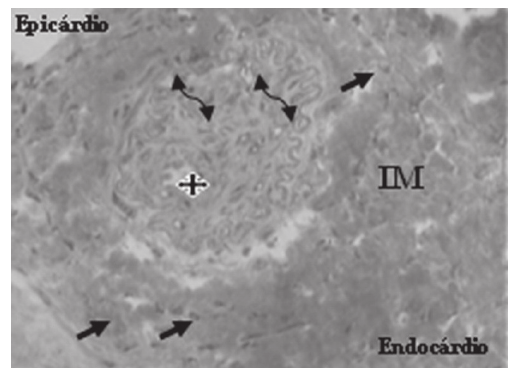
Fig. 6 - Neovaso formado (estrela), células endoteliais (flechas) e células musculares lisas (flechas duplas), após o transplante de células mesenquimais no infarto do miocárdio (IM) - Tricrômio de Gomery,